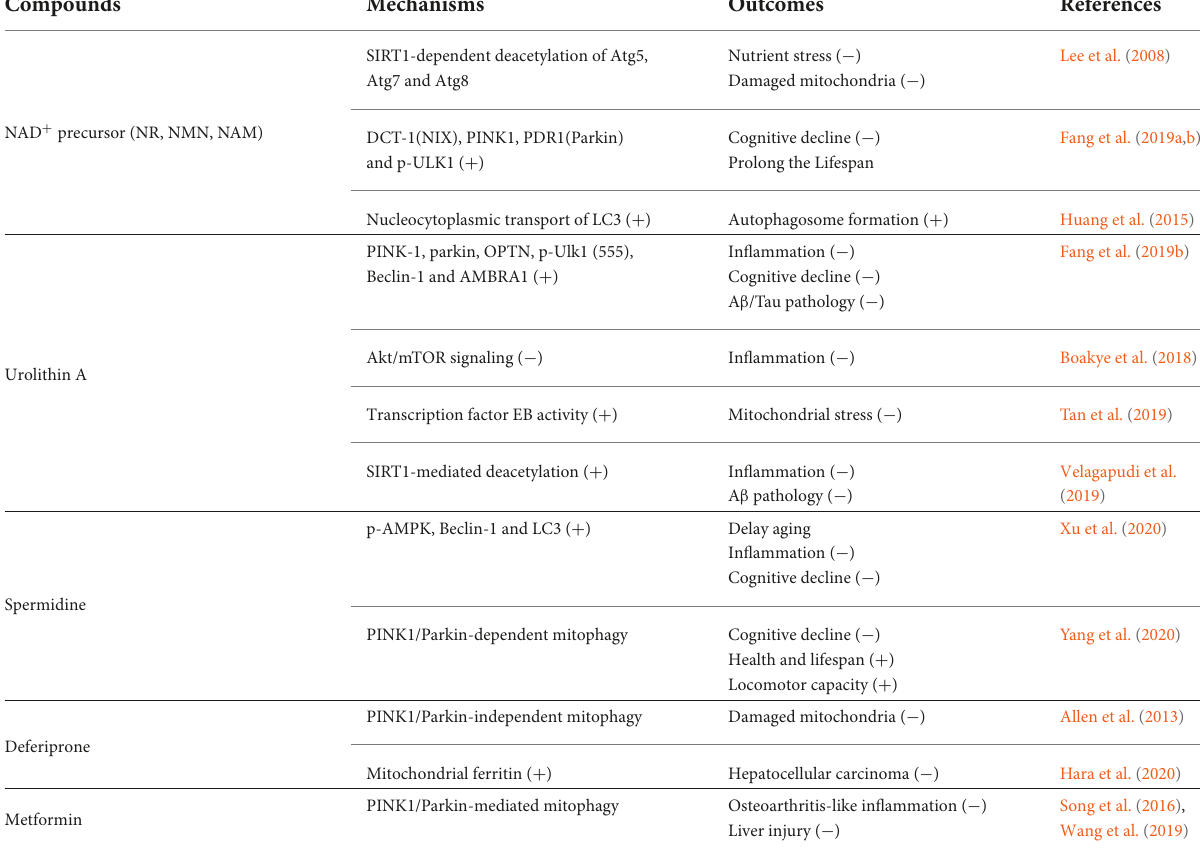
TABLE 1 Mechanisms and outcomes of mitophagy-inducing